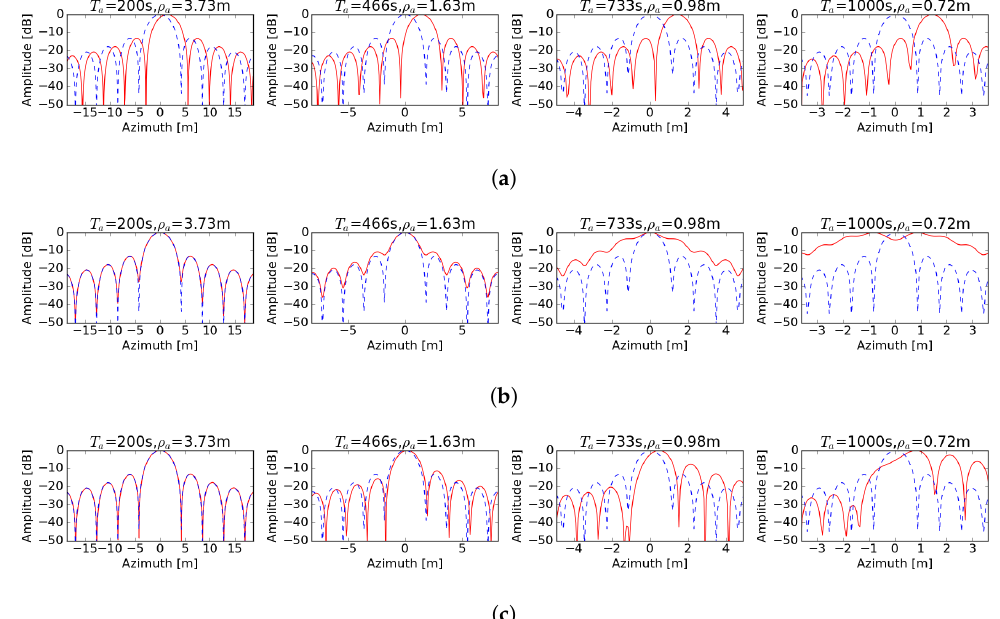
Figure 9. Influences of the time variant error on the azimuth impulse response under different integration times with the L band: ( a ) Case 0, ( b ) Case 1, and ( c ) Case 2. The blue dotted line represents the ideal result, and the red solid line represents the influenced